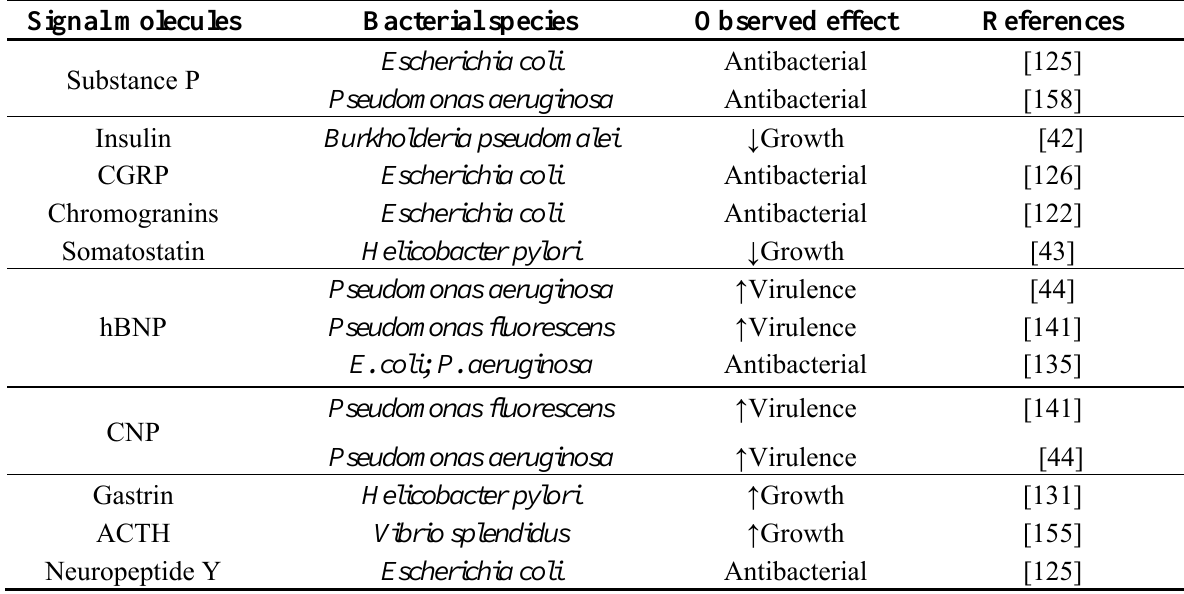
Table 3. Peptide hormones and